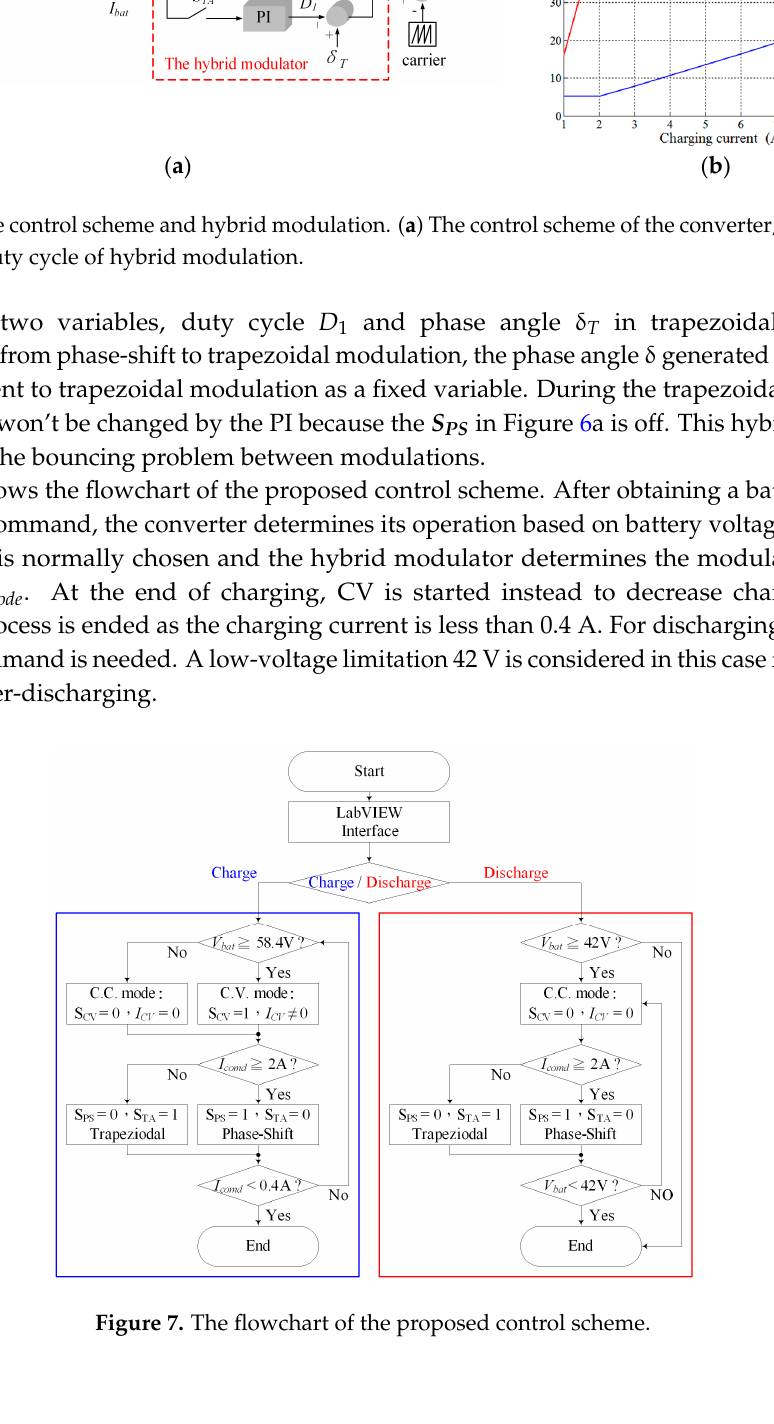
Figure 6. The control scheme and hybrid modulation. ( a ) The control scheme of the converter; ( b ) Phase angle and duty cycle of hybrid modulation.